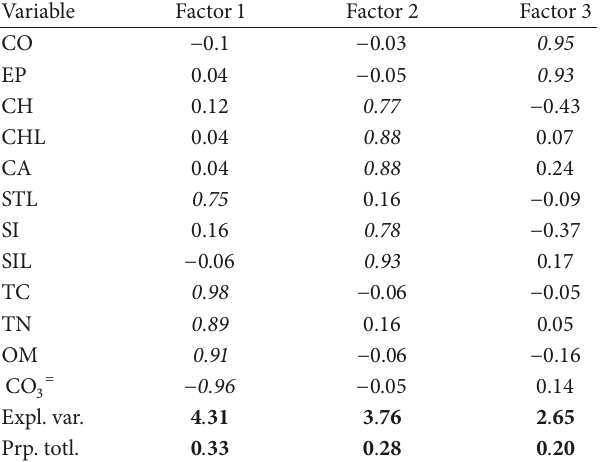
Table 3: Factor analysis for the Nortes season (Feb 2012).